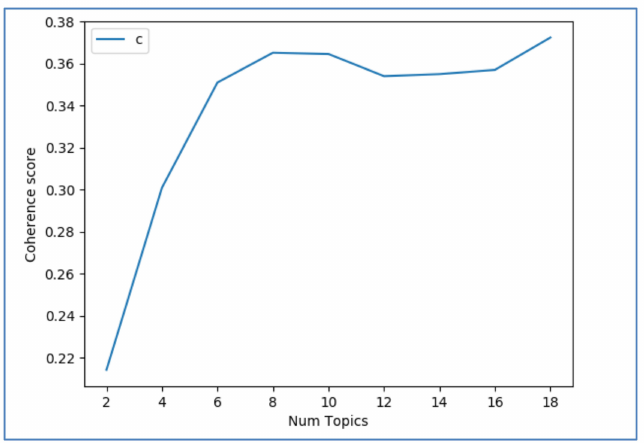
Figure 12. The optimal number of topics (Anger